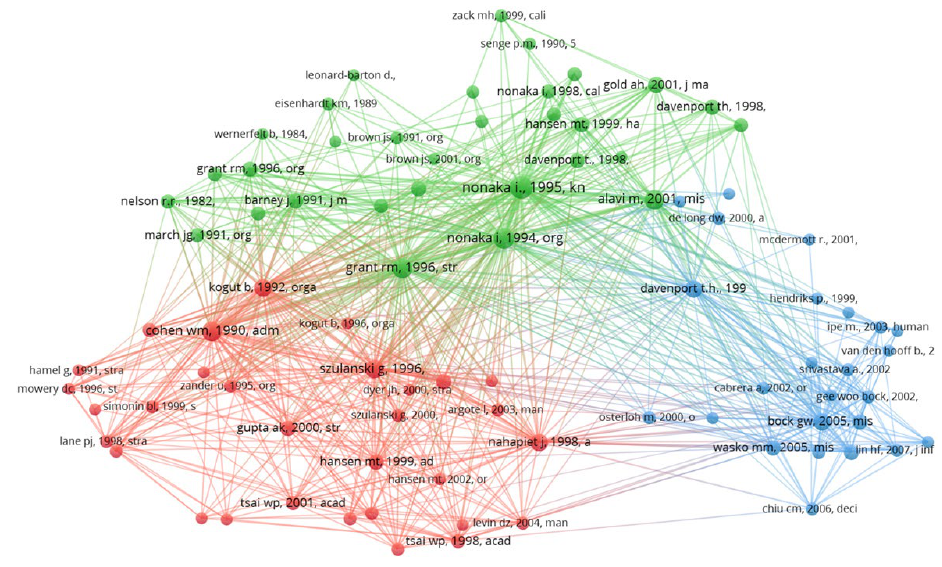
Figure 4. Articles’ co-citation